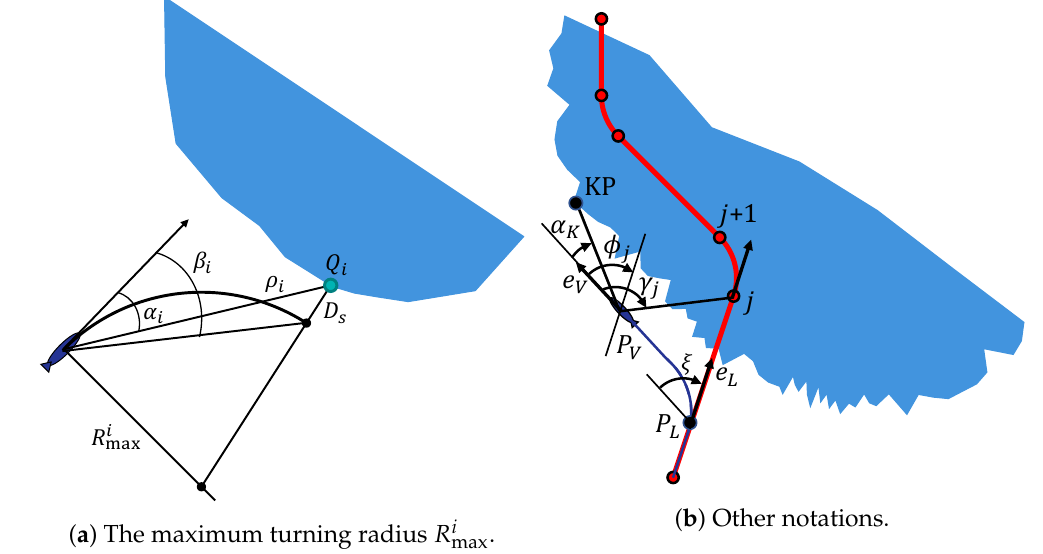
Figure 3. Introduced